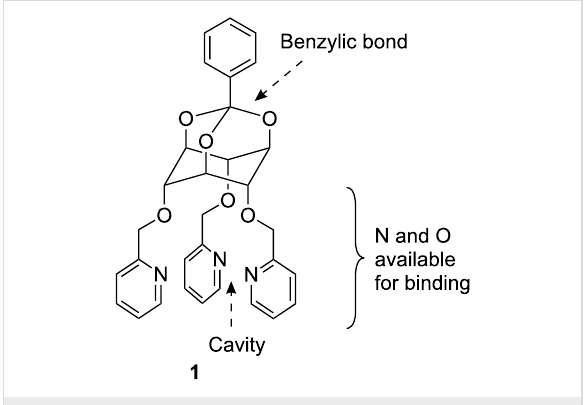
Figure 1: spatial representation of structure 1 .